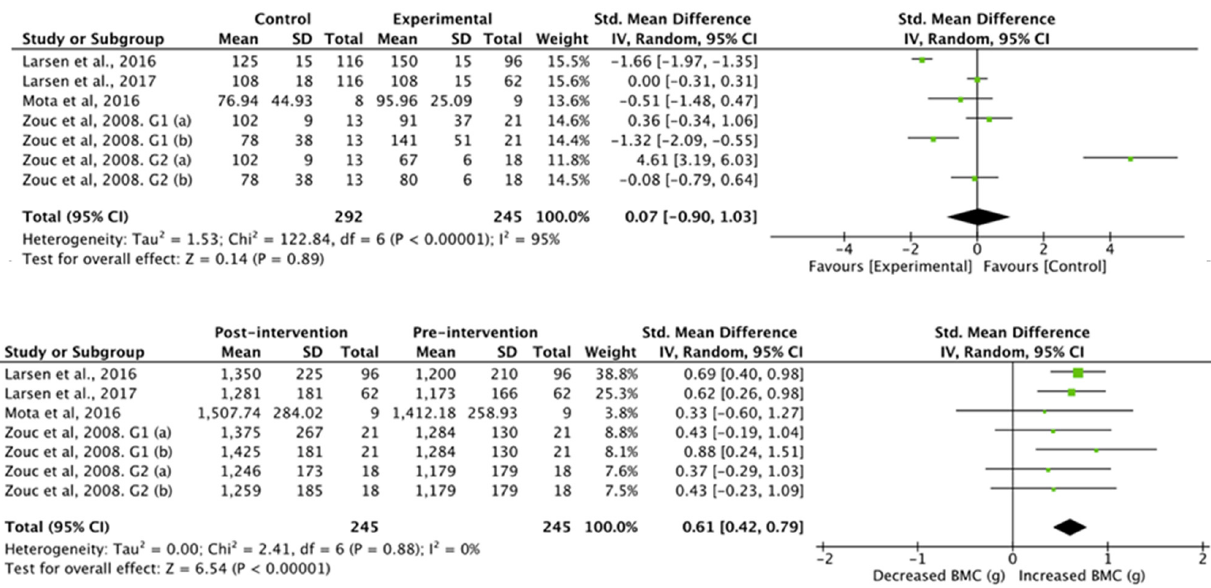
Figure 6. Results of random effects meta-analysis for the control group compared with the experimental group and results post- and pre-intervention, shown as mean difference and standardized mean difference with 95% CIs for bone mineral content [31,34,36,39]. Table 2. General characteristics the studies included in the meta-analysis.